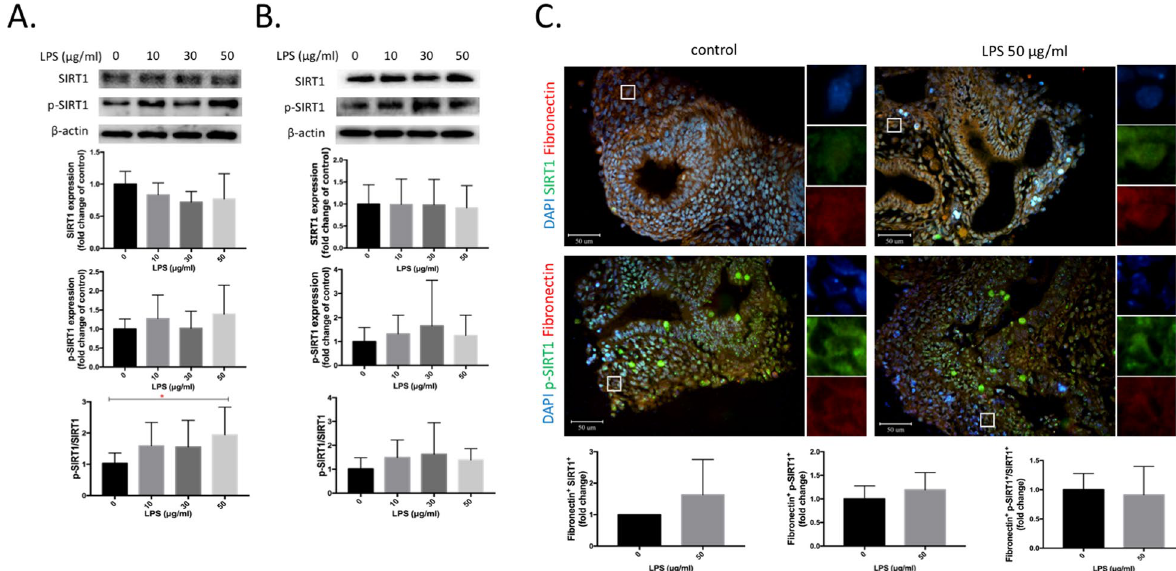
Fig. 5 Expressions of sirtuin 1 (SIRT1) and phosphorylated (p)‑SIRT1 in IMR‑90 cells, ex vivo fetal lungs, and fibroblasts of ex vivo fetal lungs by lipopolysaccharide (LPS). A Expressions of SIRT1, p‑SIRT1, and p‑SIRT1/SIRT1 in IMR‑90 cells by LPS at 0, 10, 30, and 50 μg/ml for 24 h ( n B Expressions of SIRT1, p‑SIRT1, and p‑SIRT1/SIRT1 in whole fetal lungs by LPS at 0, 10, 30, and 50 μg/ml for 3 days ( n fibronectin + SIRT1, p‑SIRT1, and p‑SIRT1/SIRT1 of fetal lungs by LPS at 0 and 50 μg/ml for 3 days. DAPI (in blue). Fibronectin (in red). SIRT1, p‑SIRT1 (in green) ( n 3). *p < 0.05 =